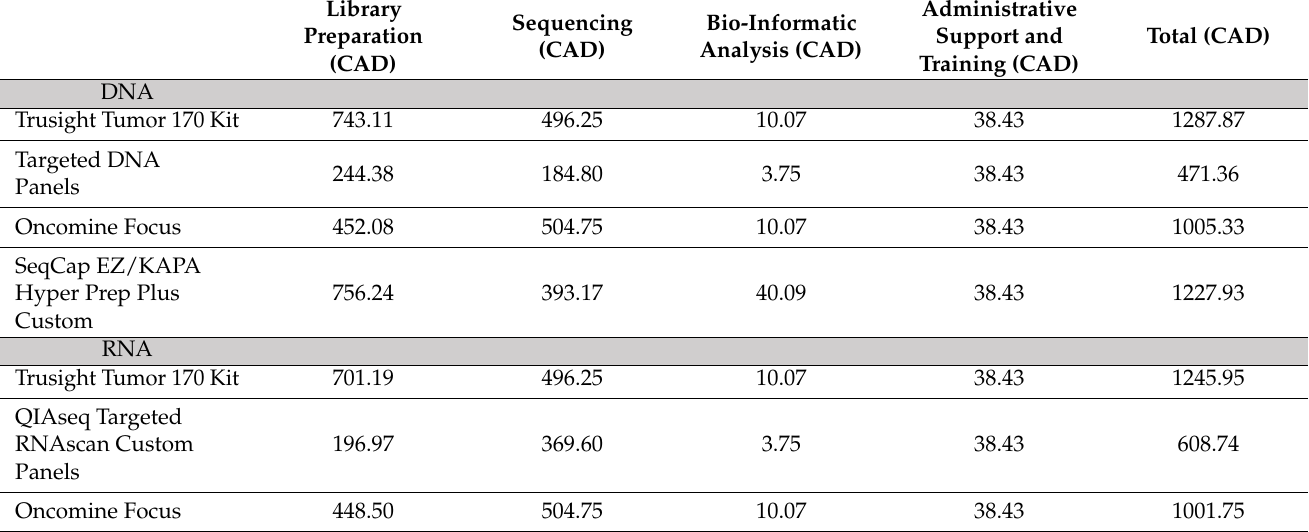
Table 1. Per-sample costs by NGS assays and testing